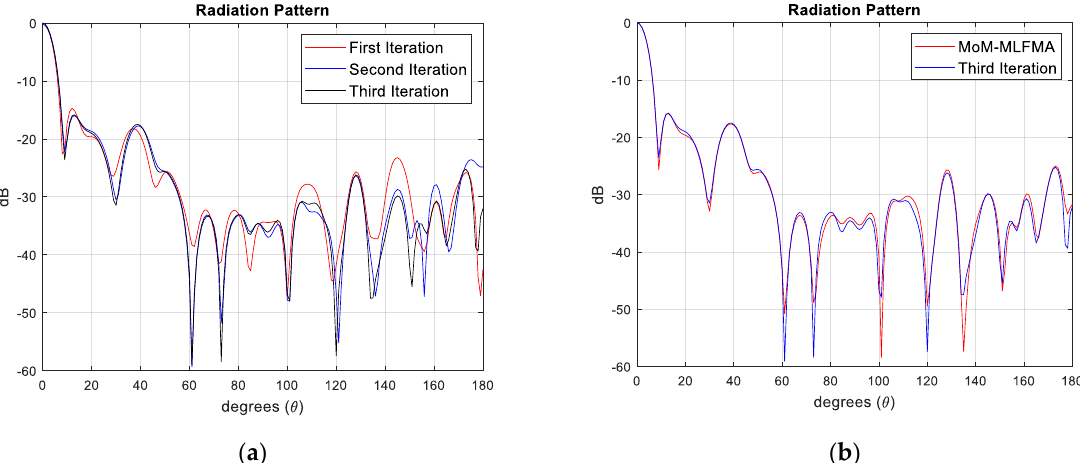
Figure 6. Radiation pattern results for the φ = 0 ° angular cut: ( a ) comparison of the proposed ap-proach considering one, two, and three iterations between domains; ( b ) comparison between the proposed approach with three iterations between domains and MoM-MLFMA (method of moments with the multilevel fast multipole algorithm).